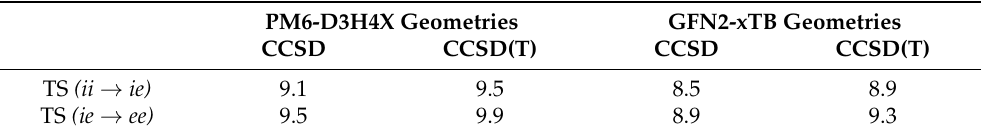
Table 4. Energetics for the main species in the system at the CCSD and CCSD(T) level on the PM6- D3H4X and GFN2-xTB geometries.